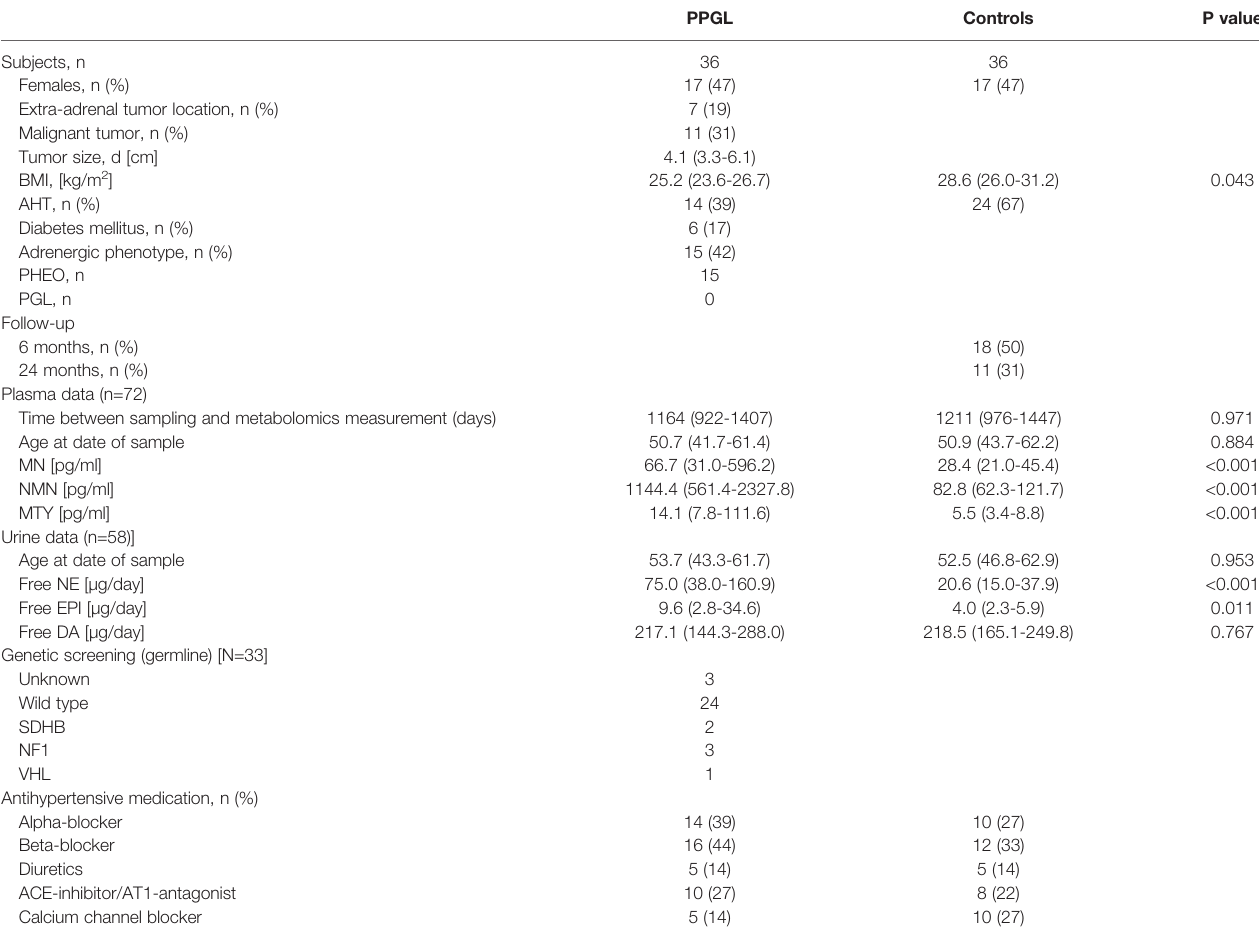
TABLE 1 | Patient characteristics strati fi ed by patients and